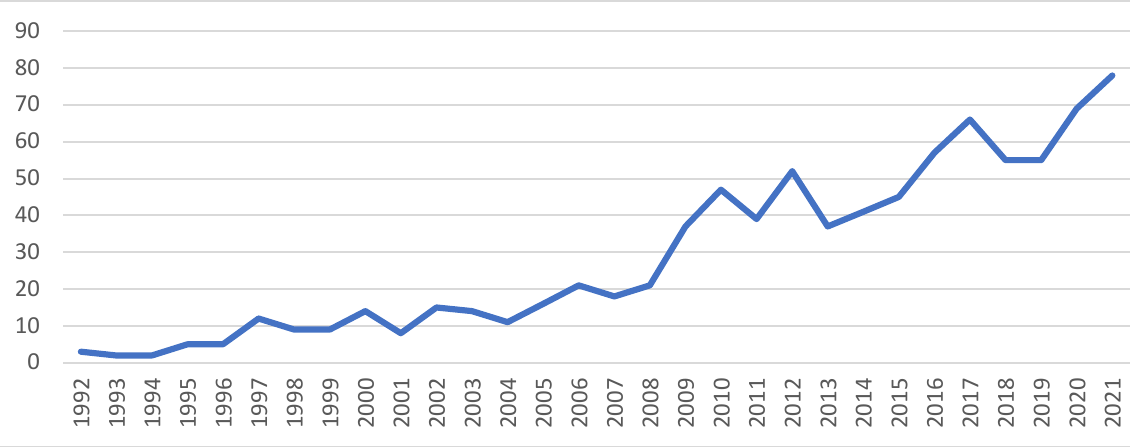
Figure 2. Annual scientific production (1992–2021). Source: Elaborated by authors using data extracted from Scopus.